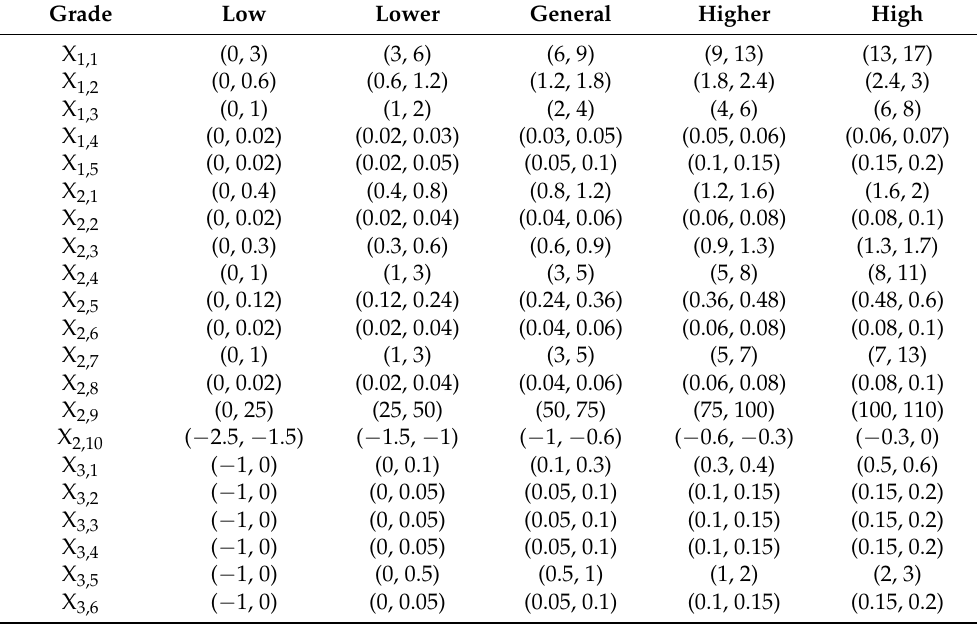
Table 6. Classification of the evaluation level of each